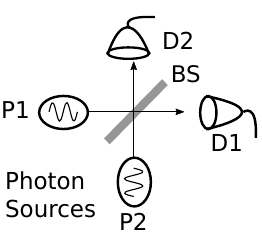
Figure 2. Quantum randomization of a photon passing through a beam splitter.